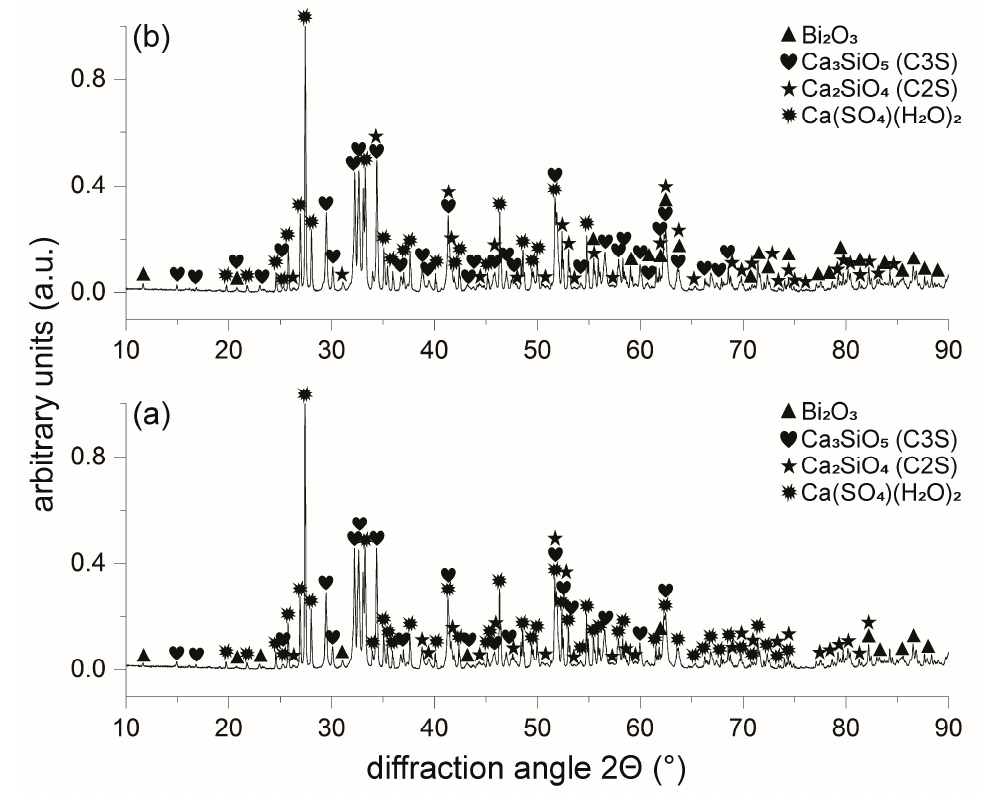
Figure 5. XRD diffractograms of the ProRoot MTA: ( a ) as received; and ( b ) after 48-h hydration. The higher reactivity of the RS+ powder allowed for in situ XRD measurements of the hydration kinetics in the 41–41.5° 2 θ range (Figure 6b). The hydration reaction was monitored by observing (012) the peak of C3S positioned at 41.148° 2 θ (PDF 00-031-0301). While there were no significant changes in the intensity of the (peak) after 5–40 min of hydration in the XRD setup, the diffraction peak was gone after 120 min, indicating